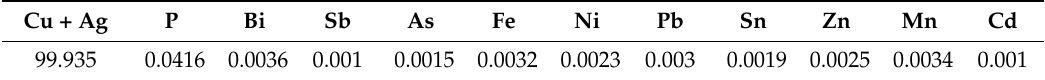
Table 1. Chemical composition of the pure copper T2 (wt%).